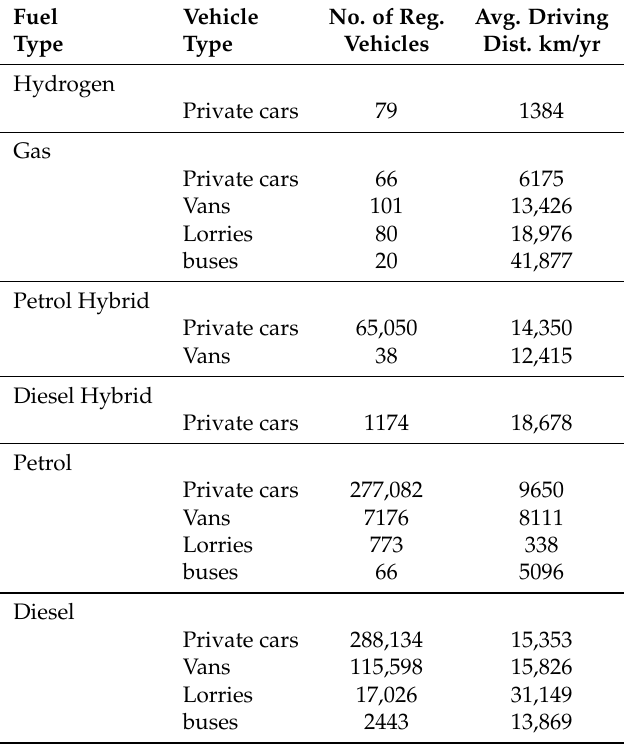
Table 3. Number of registered vehicles in the county, and average driving distance in 2018